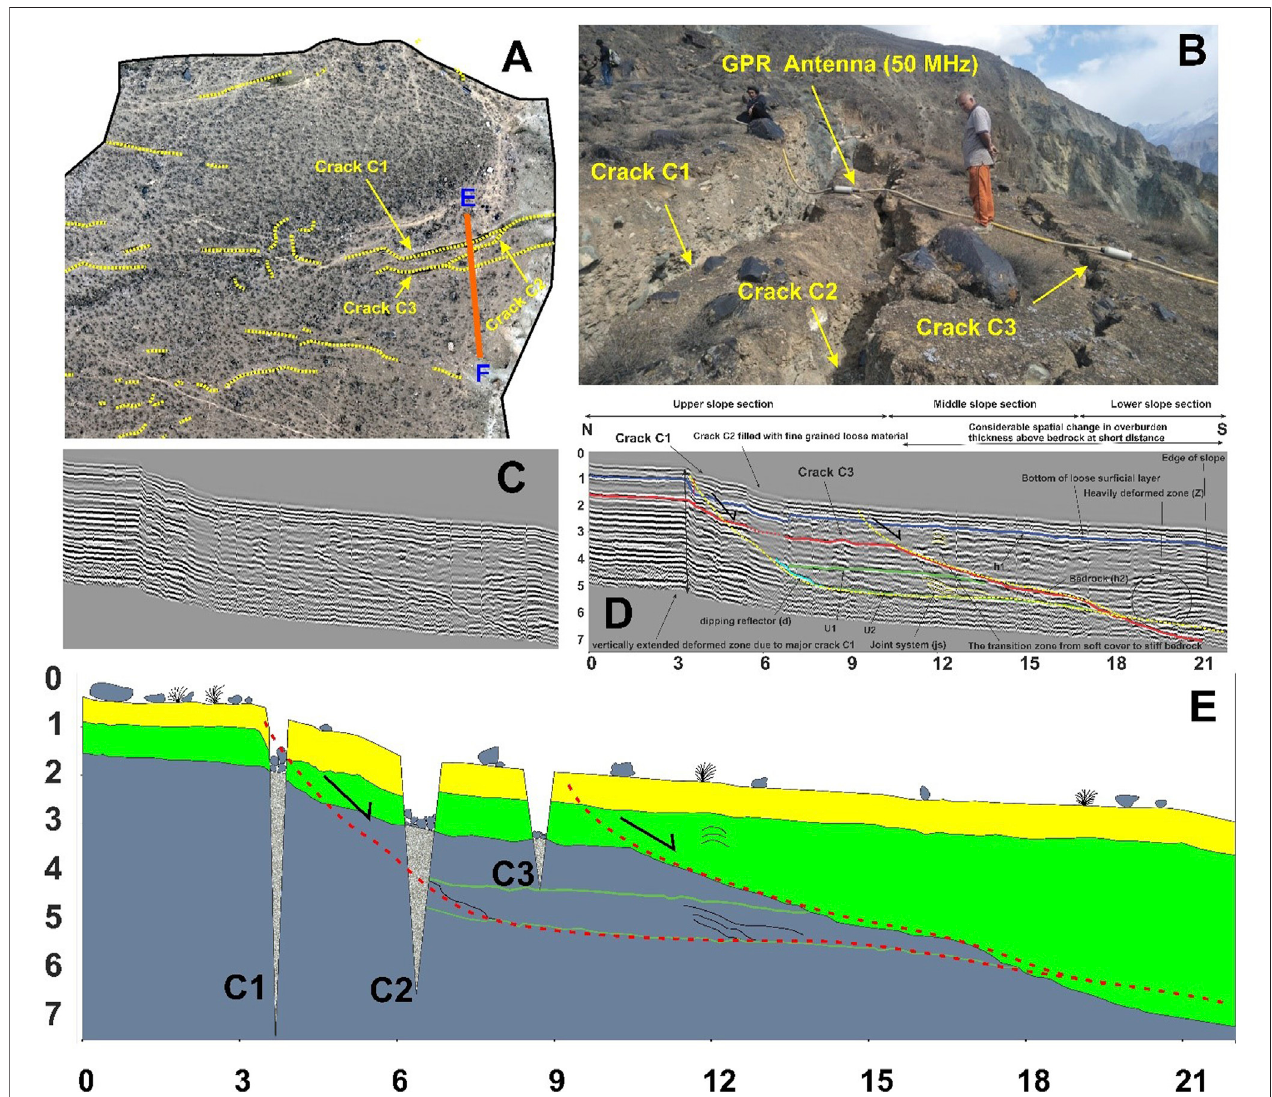
FIGURE 4 | Integration of the UAV (A) , fi eld photographs of the slope (B) uninterpreted GPR pro fi le EF and (C) interpreted GPR pro fi le, and conceptual model based on all datasets (E) . In Panel 4 (E) , C1, C2, and C3 denote main cracks, red dotted lines show slip surfaces, solid black lines represent the joint system, the lowermostdarkgreylayerrepresentsbedrock,uppermostlayerofyellowcolorshowsaloosesoftcover,andmiddlelayerofgreencolordenotesthestrati fi edpartofthe overlying sedimentary cover.